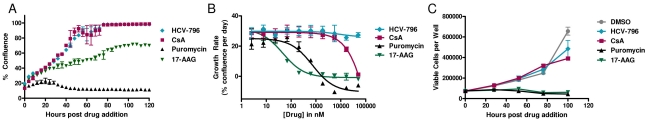
17-AAG slows cellular growth at its effective antiviral concentration.(A) Cellular growth was determined by measuring the percent confluence (by microscopic quantification) every 4 hours. HCV-796 (blue diamonds), CsA (pink squares), puromycin (black triangles), 17-AAG (green triangles). (B) Growth rate (% confluence per day) as a function of compound dose. HCV-796 (blue diamonds), CsA (pink squares), puromycin (black triangles), 17-AAG (green triangles). (C) Trypan-blue exclusion was used to determine the number of viable cells each day post drug addition. HCV-796 (blue diamonds), CsA (pink squares), puromycin (black triangles), 17-AAG (green triangles), or an equivalent volume of DMSO (grey circles).